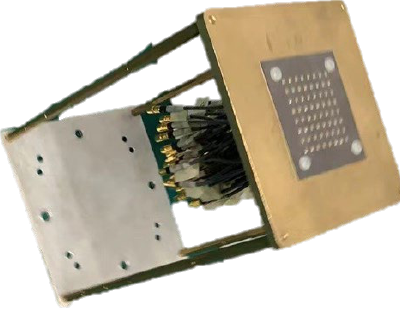
Figure 5. Ka array Figure 5. Ka array antenna. Figure 5. Ka array antenna.